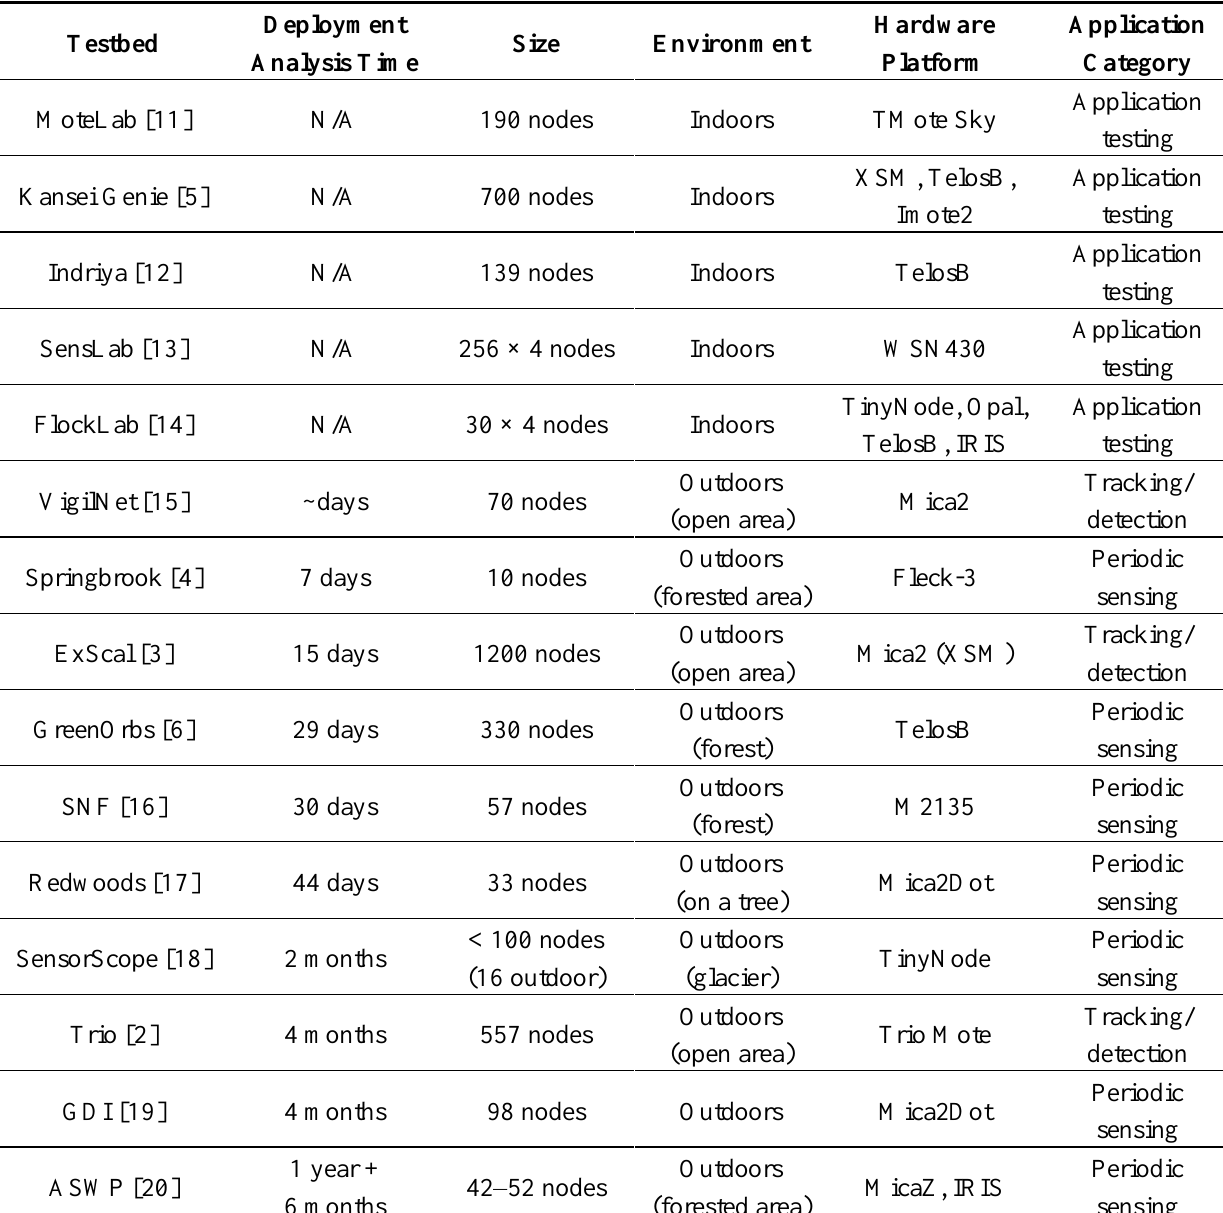
Table 1. Representative multi-hop WSN deployments from the past decade and their deployment